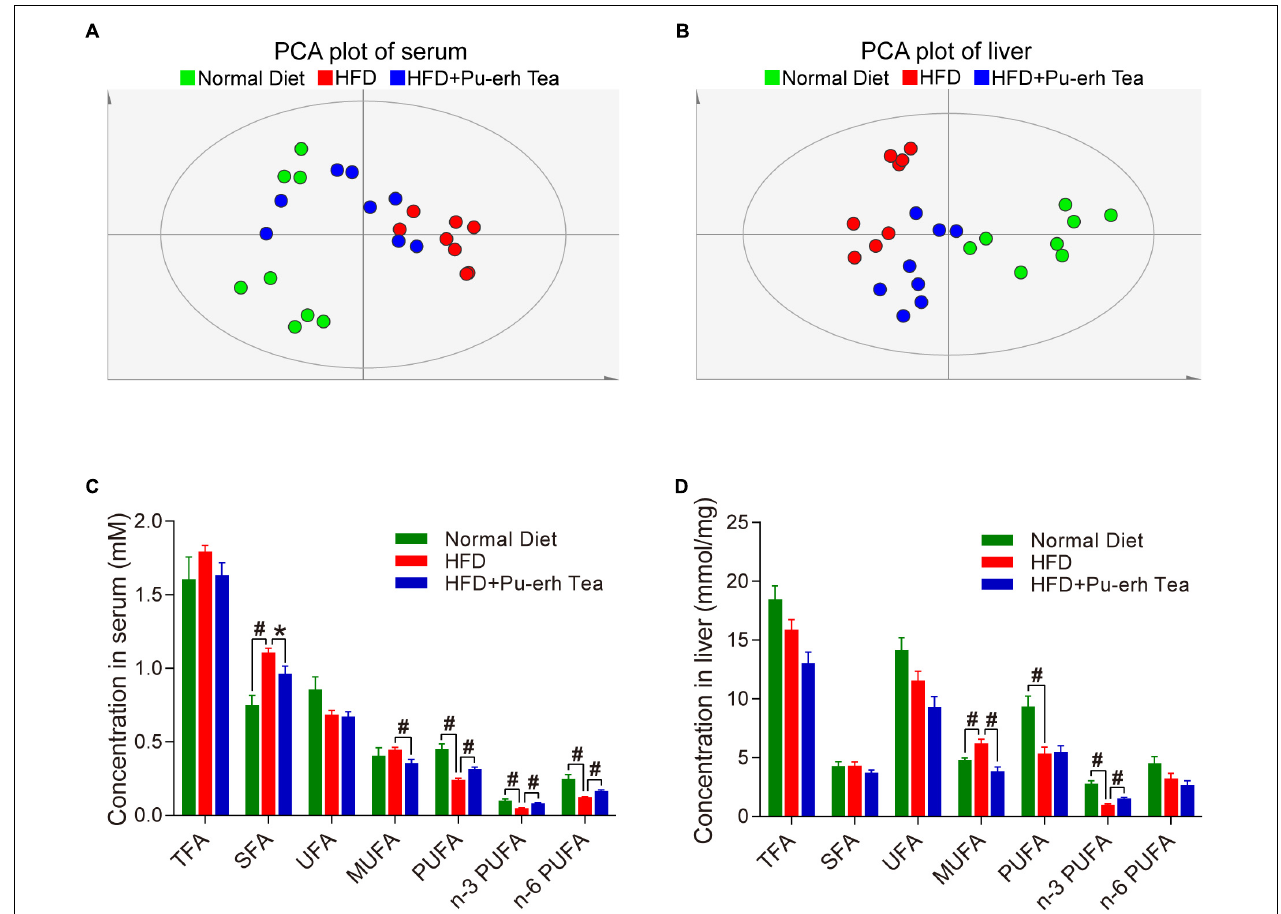
FIGURE 2 | HFD and Pu-erh tea altered FFA profiles and main FFA species in both serum and liver of mice. (A) Principle component analysis (PCA) plot based on serum FFA profile of mice fed with control diet, HFD, and HFD with 450 mg/Kg/day Pu-erh tea for 22 weeks. (B) PCA plot based on hepatic FFA profile of mice fed with control diet, HFD, and HFD with 450 mg/Kg/day Pu-erh tea for 22 weeks. (C) FFA species in serum of mice fed with control diet, HFD, and HFD with 450 mg/Kg/day Pu-erh tea for 22 weeks. (D) FFA species in liver of mice fed with control diet, HFD, and HFD with 450 mg/Kg/day Pu-erh tea for 22 weeks. Data were expressed as mean ± SEM and differences were assessed by Mann–Whitney U test, ∗ p < 0.05, # p <